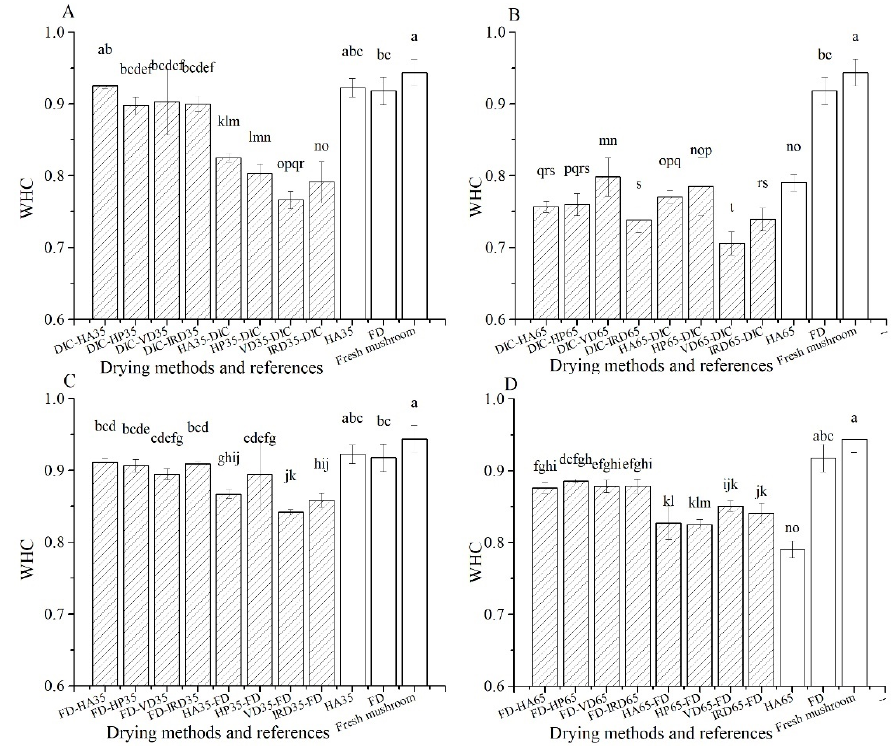
Figure 2. Volume recovery ratio of mushrooms after rehydration with different drying methods ( ) and references ( □ ). ( A–D ): group names as shown in Table1. ) and references ( (cid:3) ).